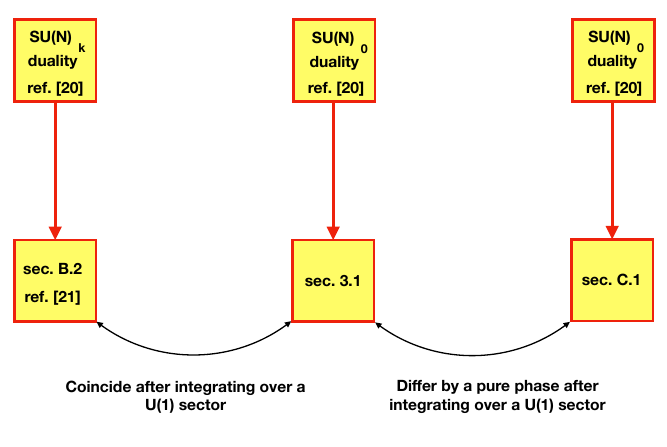
Figure 1 . The various real mass flows leading to the [ p, q ] case studied in this paper and their relation. We report the references corresponding to the UV duality where the RG flows considered here start.